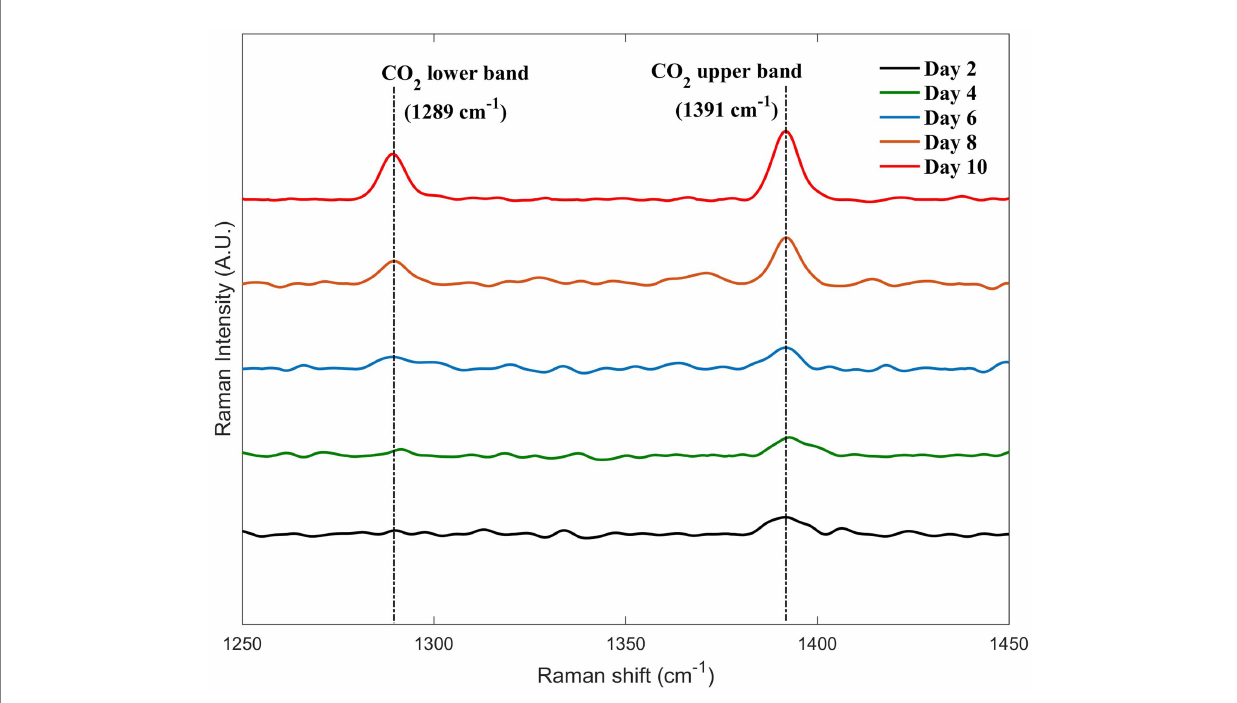
FIGURE 7 Changes in the carbon dioxide peaks during the 5 days selected from the 12-day